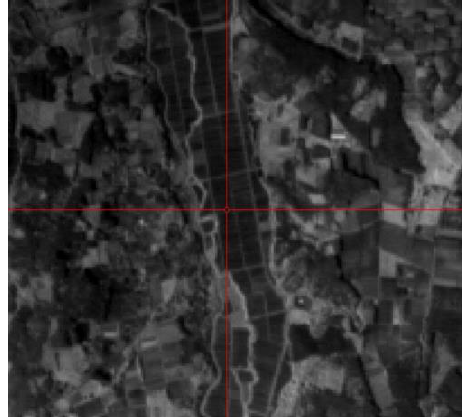
Figure 2. Experimental sample (crops) schematic